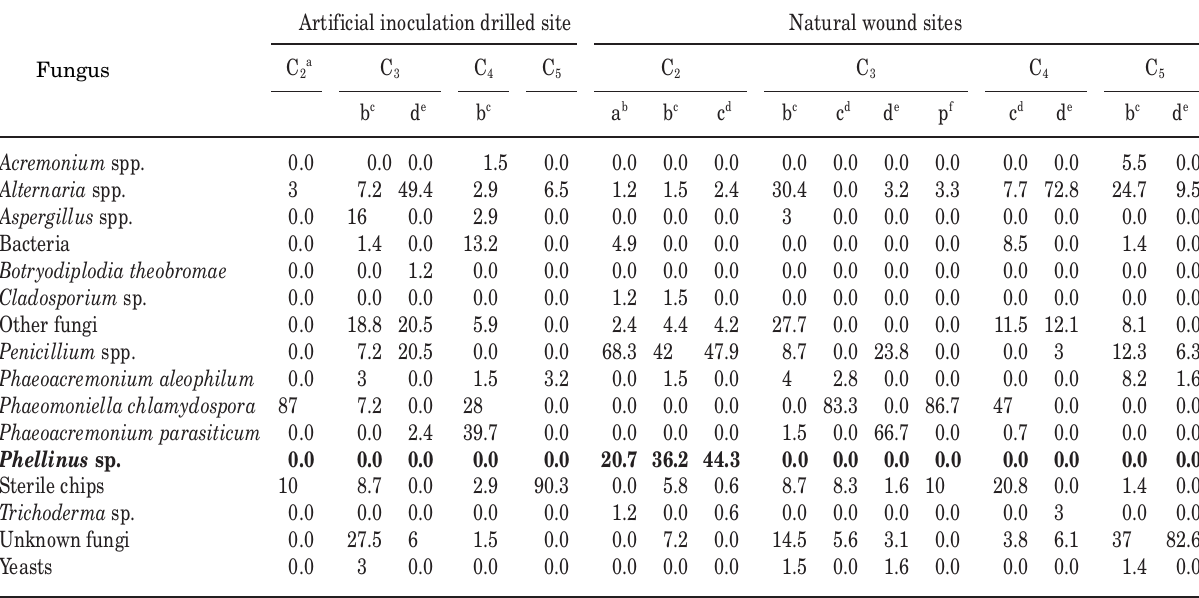
Table 4. Mycroflora isolated from discoloured wood in 4 control vines (C percentage of the total No. of colonies of each species.